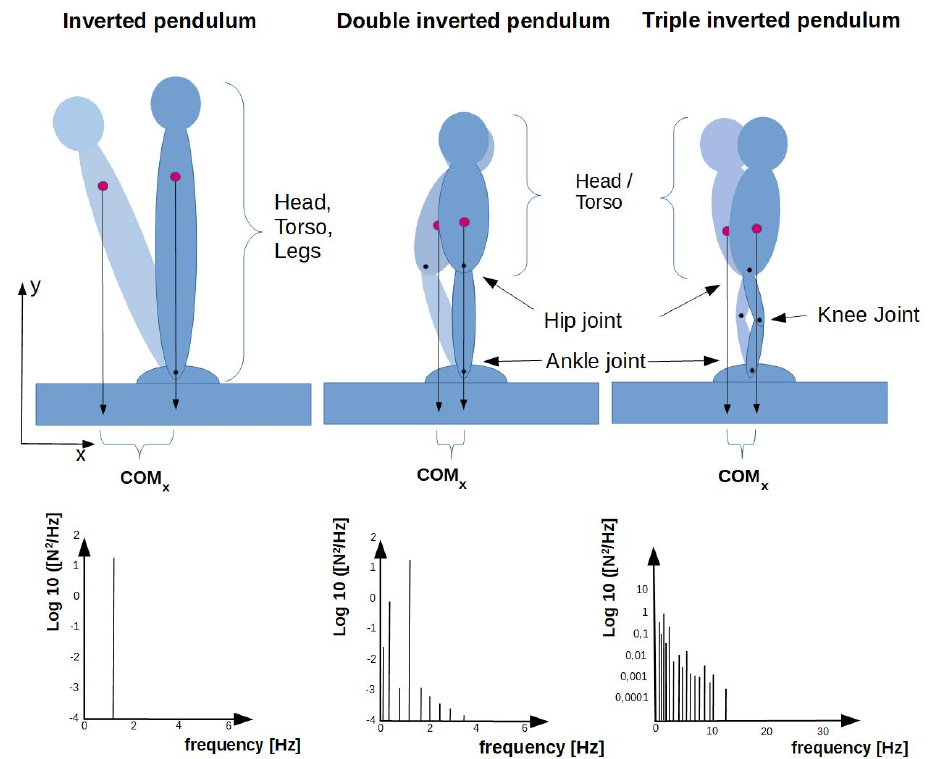
Figure 1. Representation of different models for approximating the upright position based on the inverted pendulum with mechanically inert joints to represent the physiological properties of the muscles. Left: Inverted Pendulum with one free joint; center: double inverted pendulum (DIP) with two free joints (ankle and hip); right: triple inverted pendulum (TIP) with three free joints (ankle, knee and hip) [15,28].